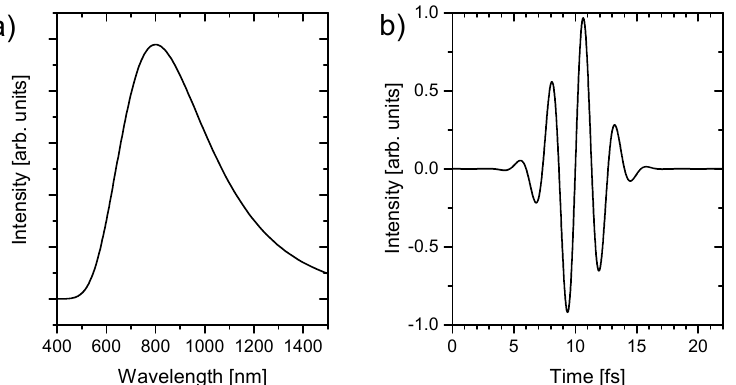
Figure 2. Excitation pulses used in the nanodisk sandwich simulations. ( a ) The spectrum; ( b ) the normalized temporal electric field. Reprinted with permission from [24] ©The Optical